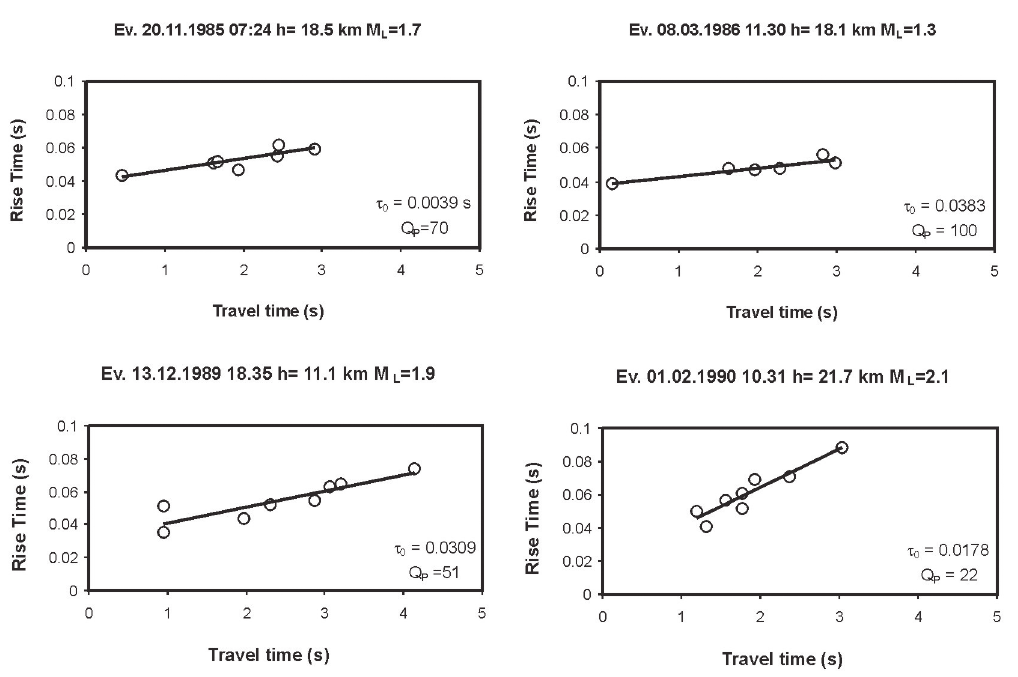
Fig. 6. Rise time vs. travel time for some events considered in this study. The best fitting straight line is also